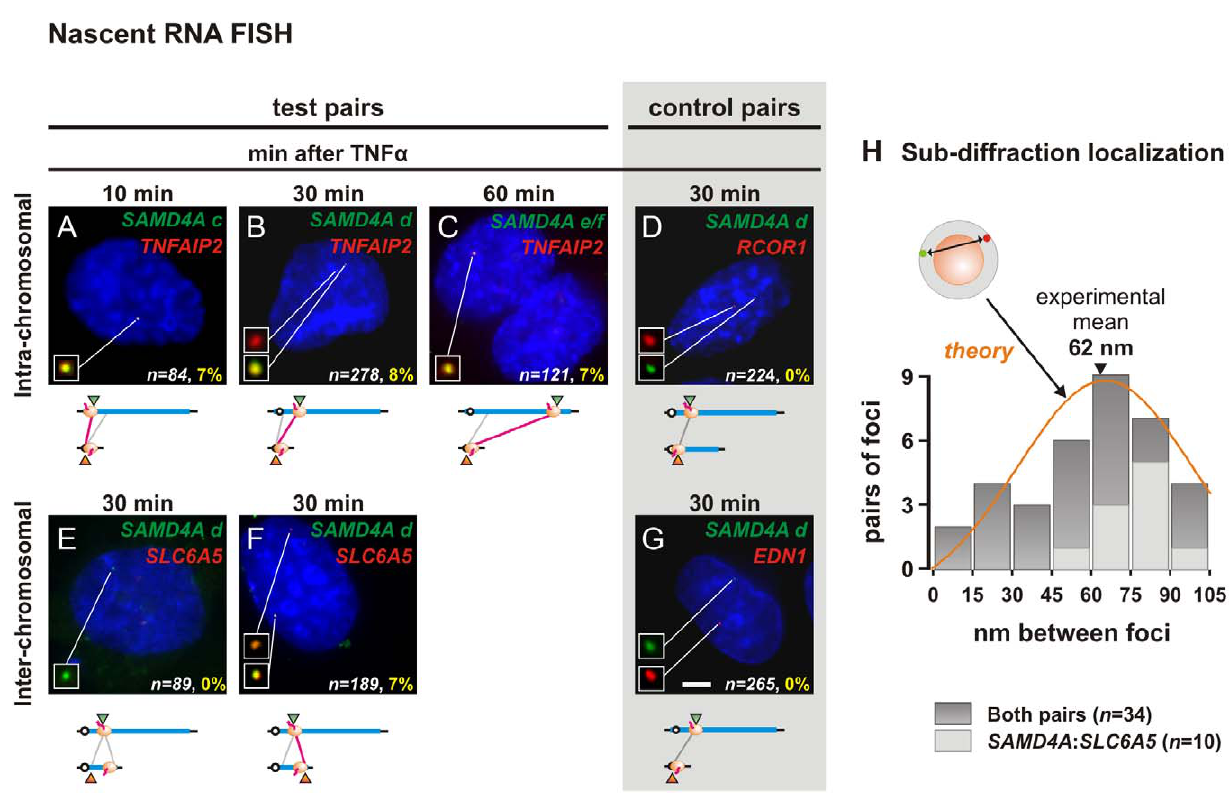
Figure 5. Colocalization of intronic RNA demonstrated by RNA FISH. HUVECs were treated with TNF a for 10, 30, or 60 min, and nascent RNAs copied from test and control pairs of genes detected by RNA FISH. (A–C) Colocalization of nascent RNAs encoded by genes on the same chromosome. The two probes target RNA copied from intron 2 of TNFAIP2 (red) and intronic region c , or d , or e/f of SAMD4A (green); representative images of DAPI-stained nuclei are shown (insets provide magnifications of foci indicated). Red and green foci mark (non-colocalizing) nascent transcripts copied from one (or both) allele, and yellow foci colocalizing ones; n gives the number of alleles active in all cells analyzed that have $ 1 green focus plus $ 1 red focus. Numbers in yellow give the fraction of colocalizing red and green foci (where . 75% pixels in one focus share red and green signal) expressed as a percentage of n ; values were significantly different from those seen in (D) with a control gene ( p , 10 2 3 , Fischer’s exact test, one-tailed). The cartoon illustrates the targets of red and green probes (triangles), and the positions of polymerases; red lines between targets indicate that yellow foci were detected (grey lines: no yellow foci detected—see Figure S5C). (D) Yellow foci were never seen with probes targeting intronic RNA copied from SAMD4A and a (non-responsive) control gene ( RCOR1 ) that lies between SAMD4A and TNFAIP2 . (E–F) Colocalization of nascent RNAs encoded by genes on different chromosomes. The two probes target RNA copied from intronic region d of SAMD4A (green) and either intron 1 or 10 of SLC6A5 (red); only the latter yields yellow foci (the number of yellow foci was significantly different from that seen in (G) with a control gene; p , 10 2 3 , Fischer’s exact test, one-tailed). (G) Yellow foci were never seen with probes targeting intronic RNA copied from SAMD4A and a (non-responsive) control gene ( EDN1 ) that lies on a different chromosome from SAMD4A . Bar: 5 m m. (H) Sub-diffraction localization of peaks of red and green signal within yellow foci. Gaussian curves were fitted to the intensities of the red and green signals, and distances between peaks determined with a precision of 15 nm (see Methods for details). Dark grey bars illustrate distances obtained from 34 yellow foci seen in images like those in (B) and (F); the mean distance is 62 nm. Light grey bars illustrate similar distances obtained from 10 yellow foci like that in (F). The model shows a red and green point randomly distributed in a 35 nm shell (grey) around an 87 nm diameter factory (orange sphere); simulations using this model yield the distribution indicated (orange line). the diffraction limit of the light microscope [21–23]. We assume the red and green signals that yield a yellow focus (e.g., Figure S5B) mark two sub-diffraction spots, fit Gaussian curves to their intensities, and measure the distance (with 15 nm precision) between peaks [23]; the distance between the two transcripts ranges from 7 to 102 nm, with a mean separation of 62 nm (Figure 5H). This distribution is much like that seen when a pair of red and green points are repeatedly and randomly distributed in a 35 nm shell surrounding an 87 nm diameter sphere (Figure 5H, orange line). [Subdiffraction- sized red/green fluorescent beads of 110 nm serve as a truly co- localizing control (Figure S5B, left); then, the distance between their red and green peaks is within the uncertainty of our measurements ( n =8; not shown).] These results are consistent with nascent transcripts copied from the two different genes lying on the surface of the same transcription factory.